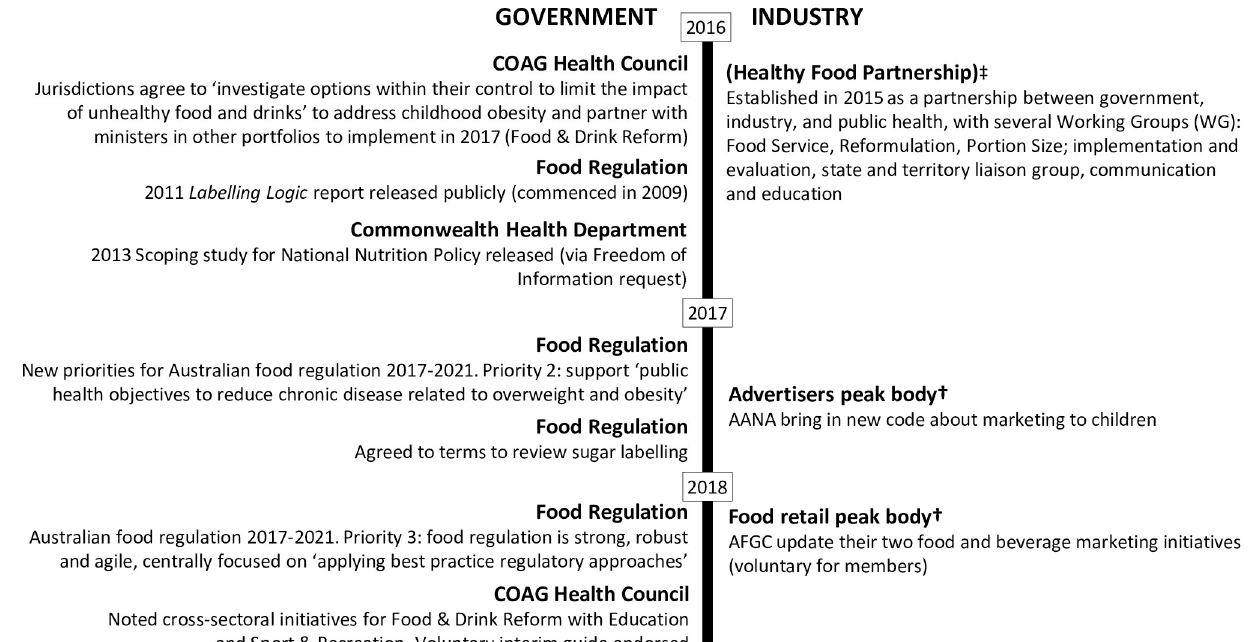
COAG Health Council, not through FSANZ processes. The Food & Drink Reform project had five programs of work. The first three were in settings children were likely to attend (health, school, and sport and recreation spaces), the fourth focused on food promotion within state/